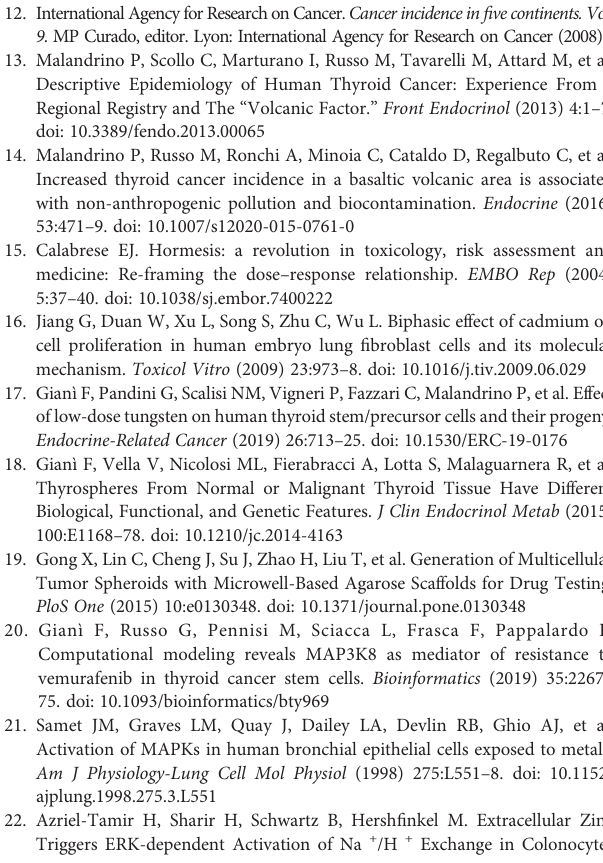
Supplementary Figure 1 | Pre-treatment with PD98059 inhibits ERK1/2 phosphorylation induced by metals in thyrospheres. (A) Thyrospheres pre-treated or not with PD98059 (20 m M for 30 min) were exposed to the studied metals or their mixture for 5 min. Western blot analysis was then carried out in thyrospheres ’ whole lysates to evaluate ERK1/2 phosphorylation. A representative immunoblot from three independent experiments is shown. (B) Histograms represent the mean ± SEM of densitometric values normalized to vinculin and expressed as percent of control (not treated) thyrospheres. *p < 0.05; **p < 0.01 and ***p <0.001 comparing ERK1/2 phosphorylation in the absence or the presence of